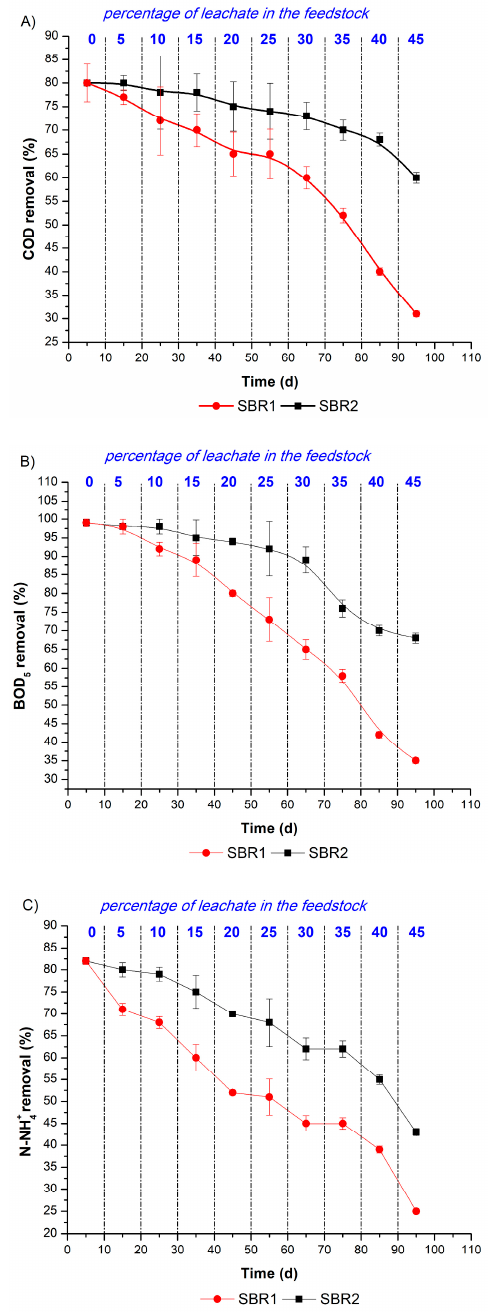
Figure 7. Variation of treatment efficiency during the experiment: ( A ) COD removal, ( B ) BOD 5 removal, ( C ) N-NH 4+ removal.